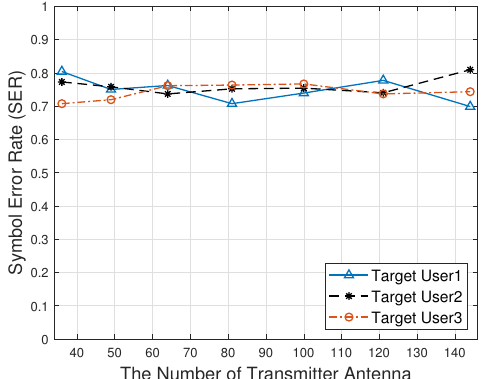
Figure 12. The symbol error rate against the number of the transmitter